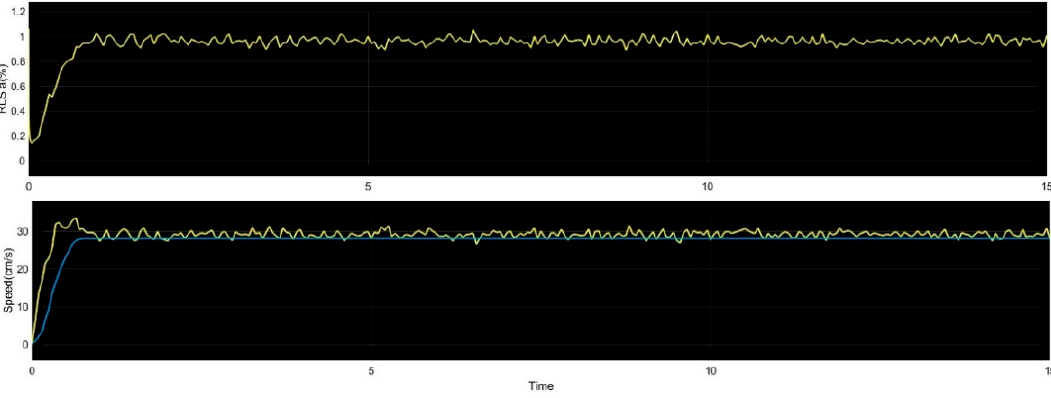
Figure 9. Estimated value by RLS method, motor speeds, and the vehicle speed of the fourth motor.